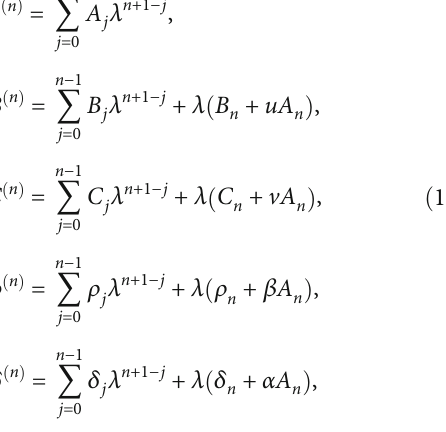
v ffiffiffiffiffiffiffiffiffiffiffiffi